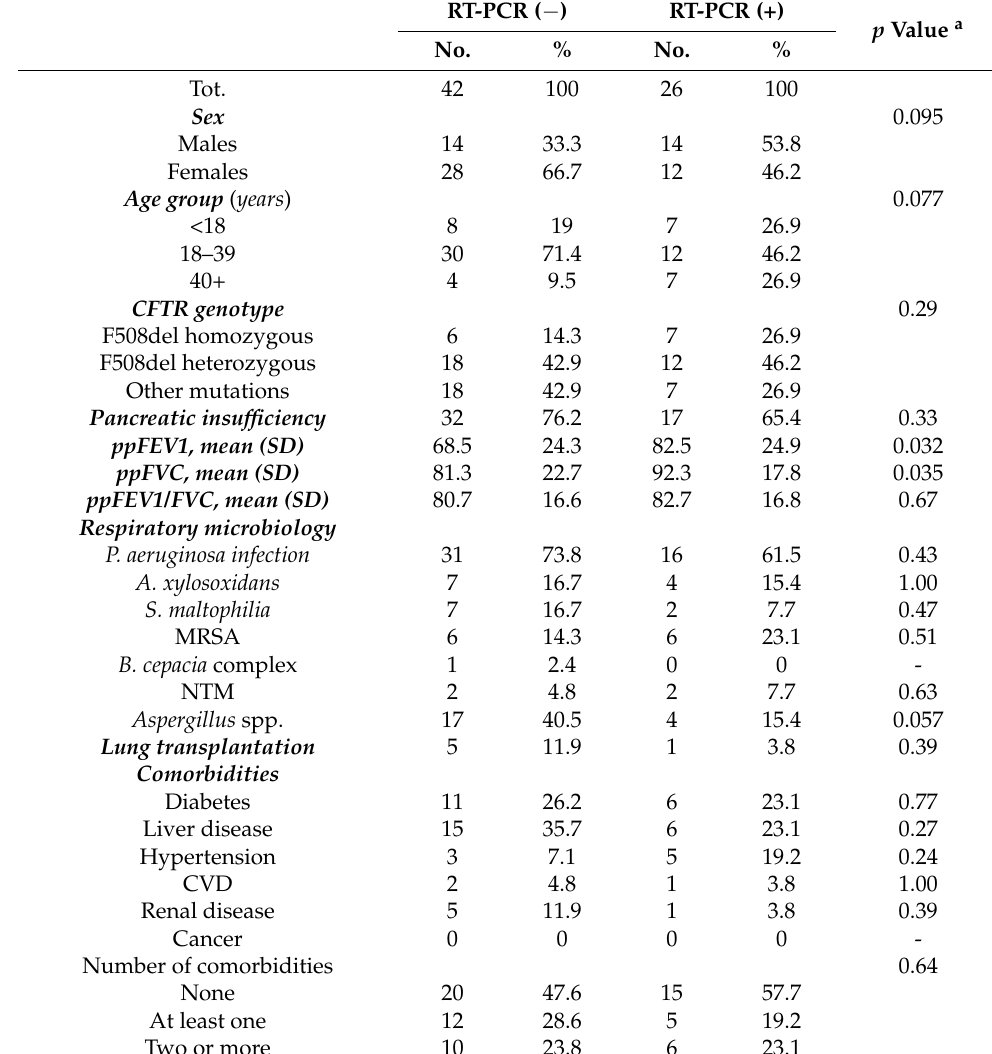
Table 1. Characteristics of the study population according to SARS-CoV-2 infection